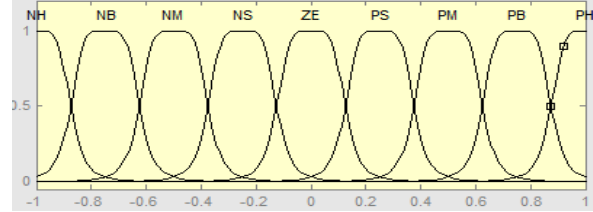
Figure 5. Membership functions of the input variables FLREM